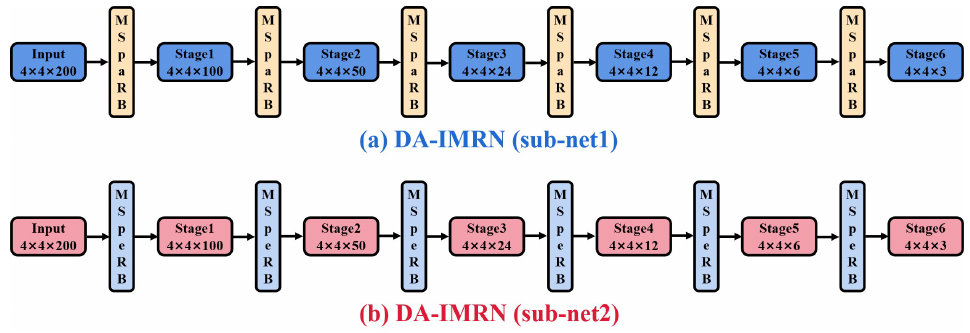
Figure 7. The structure of ( a ) DA-IMRN (sub-net1) and ( b ) DA-IMRN (sub-net2). MSpaRB represents the multi-scale spatial residual block; MSpeRB represents the multi-scale spectral residual